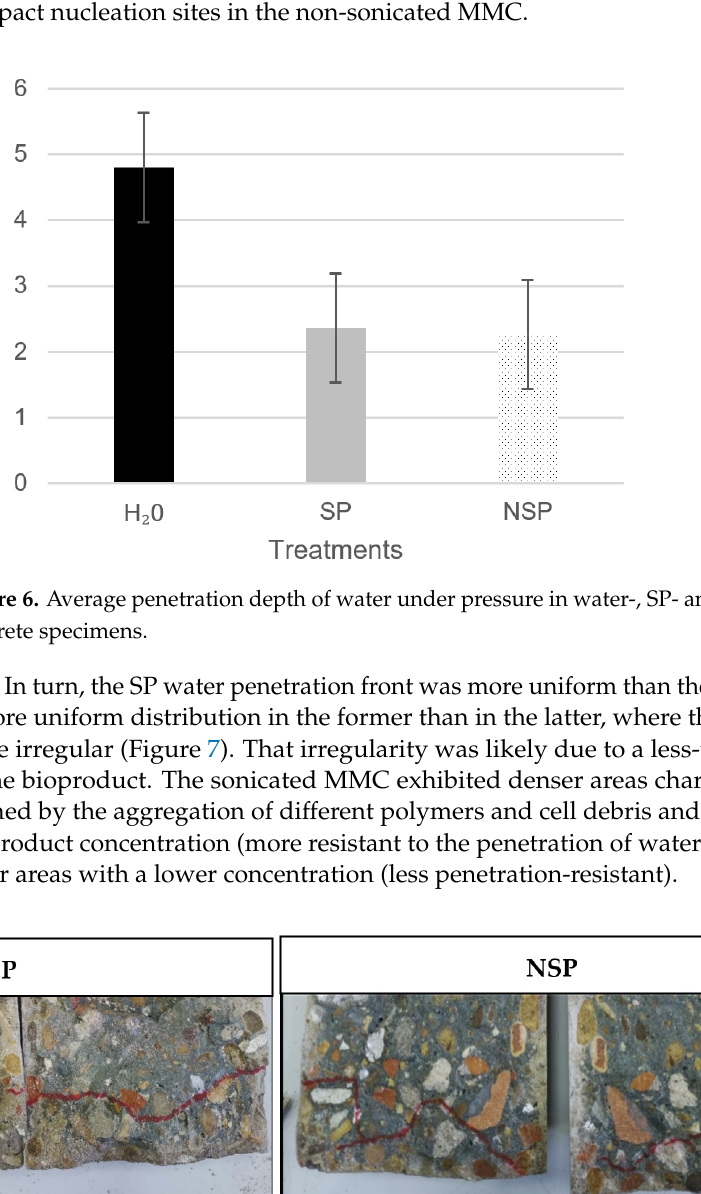
Figure 5. SEM images after 450 days and nine water drop tests. ( a ) an SP sample, and ( b ) an NSP sample.